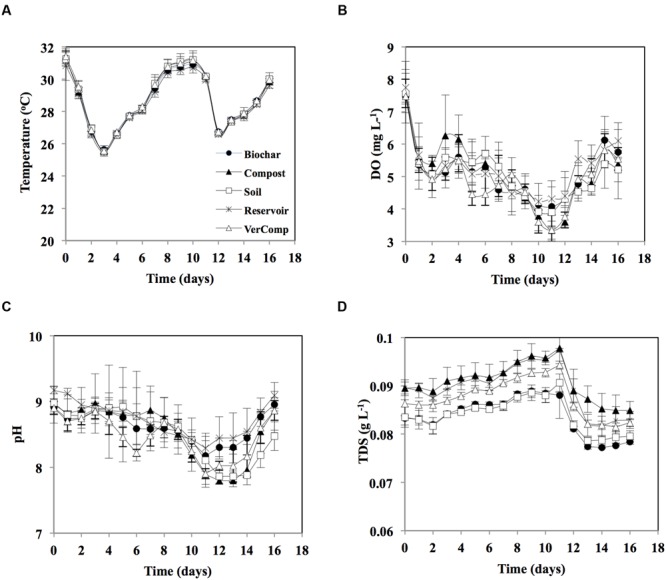
Environmental parameters during 16 days incubation. (A) Temperature (°C); (B) Dissolved oxygen (DO; mg L-1); (C) pH; and (D) Total dissolved solids (TDS, mg L-1). The mean and standard deviation is given for each treatment (n = 3).